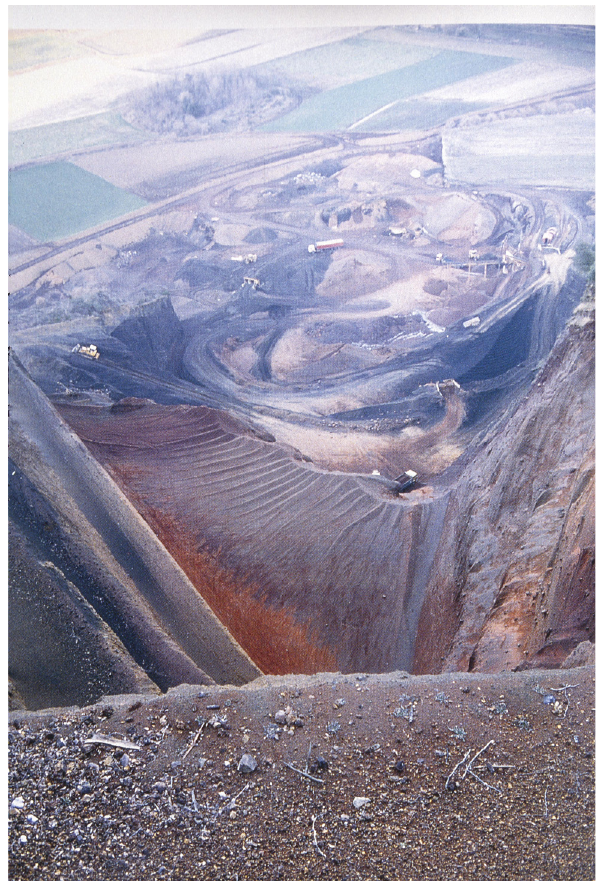
Figure 4: Extractions at the Croscat volcano, around 1980. Source: Lluís Pallí Buxó. Universitat de Girona. Biblioteca. Fons Lluís Pallí: register